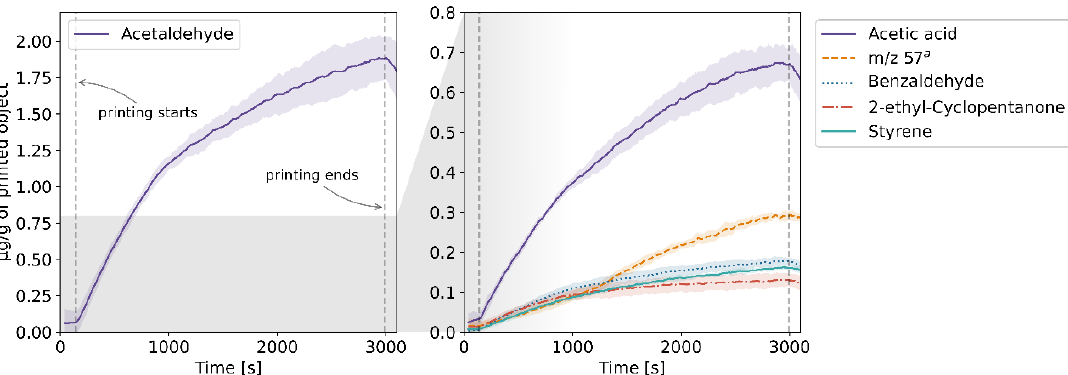
Figure 6. The mixing ratio of main VOCs within the enclosure during FFF 3D printing with the Nylon filament. a see Figure 5 caption.